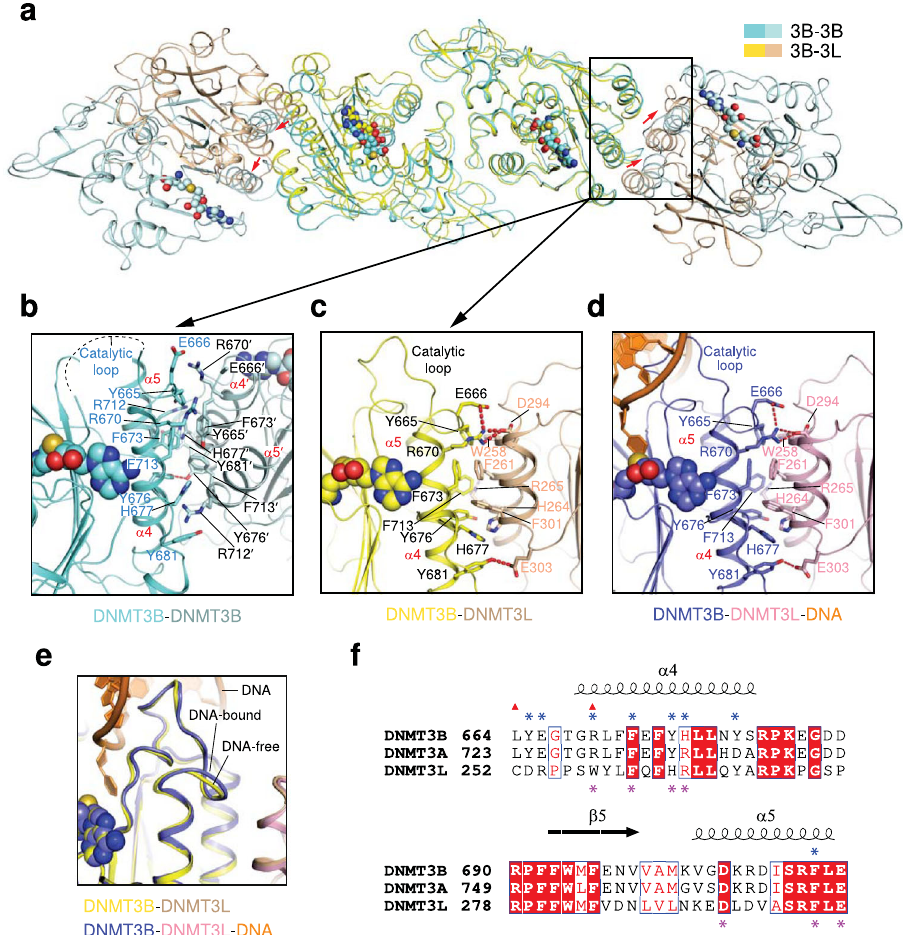
Fig. 2 Structural comparison between DNMT3B homo-oligomer and the DNMT3B-DNMT3L complex. a Structural overlay of the tetrameric unit of DNMT3B homo-oligomer (aquamarine and light blue) and the DNMT3B (yellow)-DNMT3L (wheat) (PDB 6KDP) complexes. 3B: DNMT3B, 3L: DNMT3L. Close-up view of the FF interface and the catalytic loop of DNMT3B in the DNMT3B homo-oligomer ( b ) and the DNMT3B-DNMT3L heterotetramer ( c ) that are overlaid in a . In b the disordered catalytic loop is shown as a dashed line. Residues from the symmetry-related DNMT3B monomer are indicated by prime ( ′ ). d Close-up view of the FF interface and the catalytic loop of DNMT3B in DNA (orange)-bound DNMT3B (slate)-DNMT3L (light pink) complex (PDB 6U8P). e Close-up view of the catalytic loop aligned between DNA-free and DNA-bound DNMT3B-DNMT3L complexes. f Structure-based sequence alignment of human DNMT3B, DNMT3A and DNMT3L. Identical residues are colored white in red background. Similar residues are colored red. The ICF mutations are marked by red triangles on top of the sequences. The residues involved in the intermolecular interactions at the FF interfaces of DNMT3B and DNMT3L are marked by blue and purple asterisks, on top and at the bottom of the sequences,